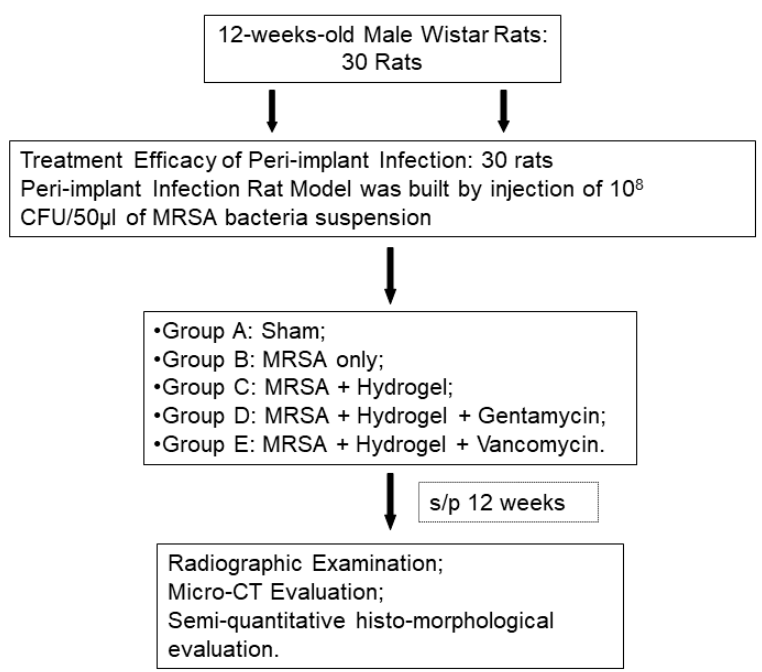
Figure 1. Flow chart of experimental design. Table 1. Experimental treatment-design of peri-implant